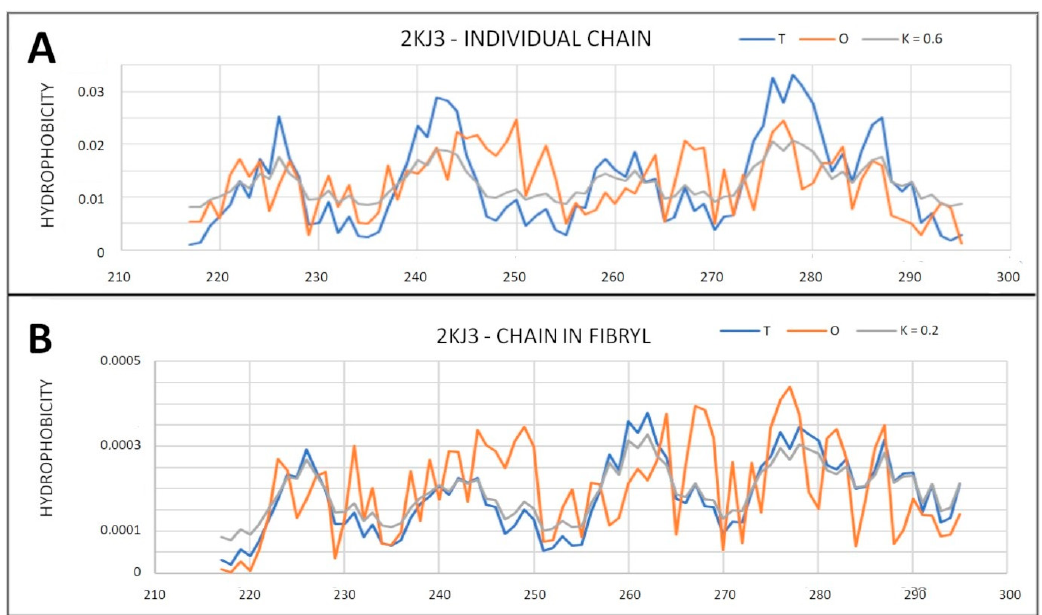
Figure 15. T, O and M profiles for amyloid showing a micelle-like structure—2KJ3. ( A ) Status of an individual chain; ( B ) Status of the chain as a component of the fibril.